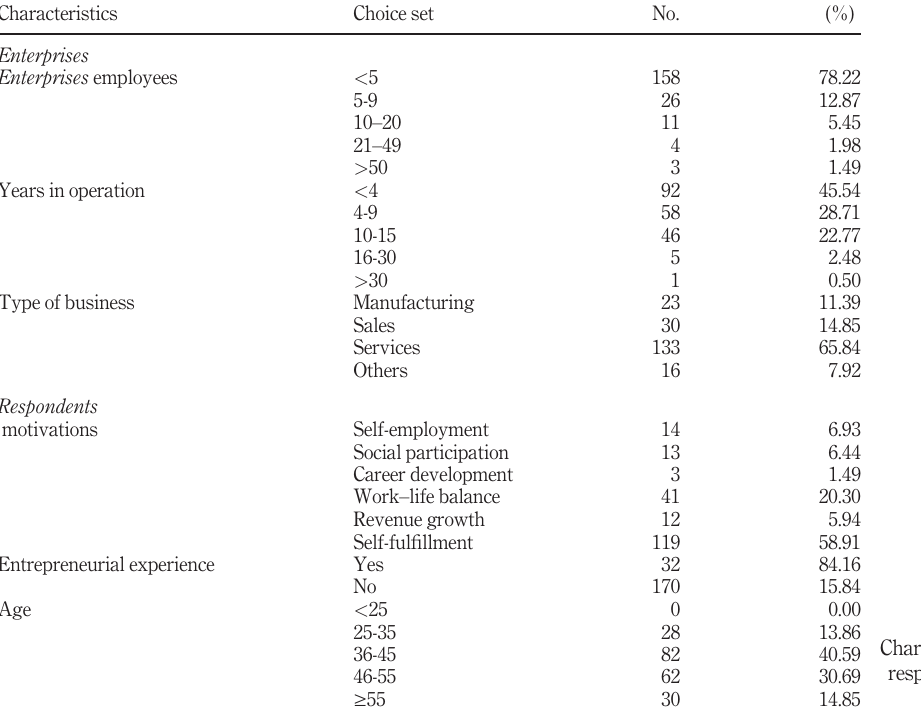
Table I. Characteristics of